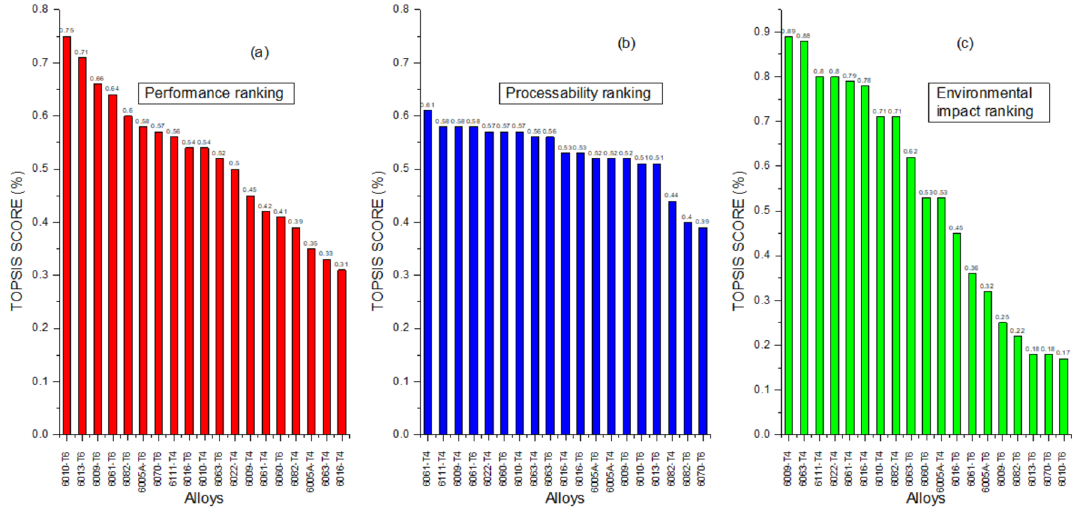
Figure 10. 6000 alloy rankings for the 3 planned scenarios through TOPSIS: (a) performance, (b) processability and (c) environmental